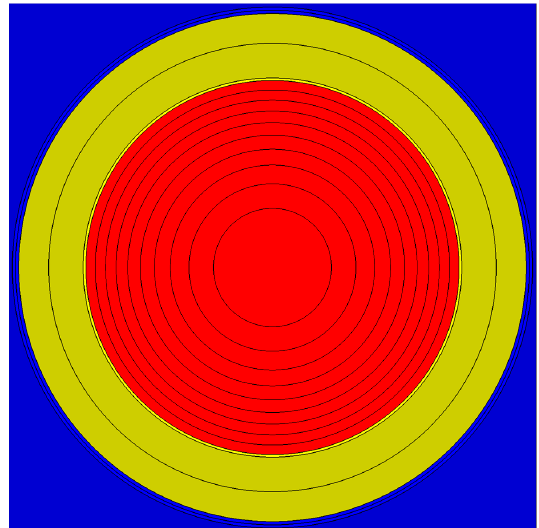
Figure 2. Model of the molten salt reactor core surrounded by an absorber.